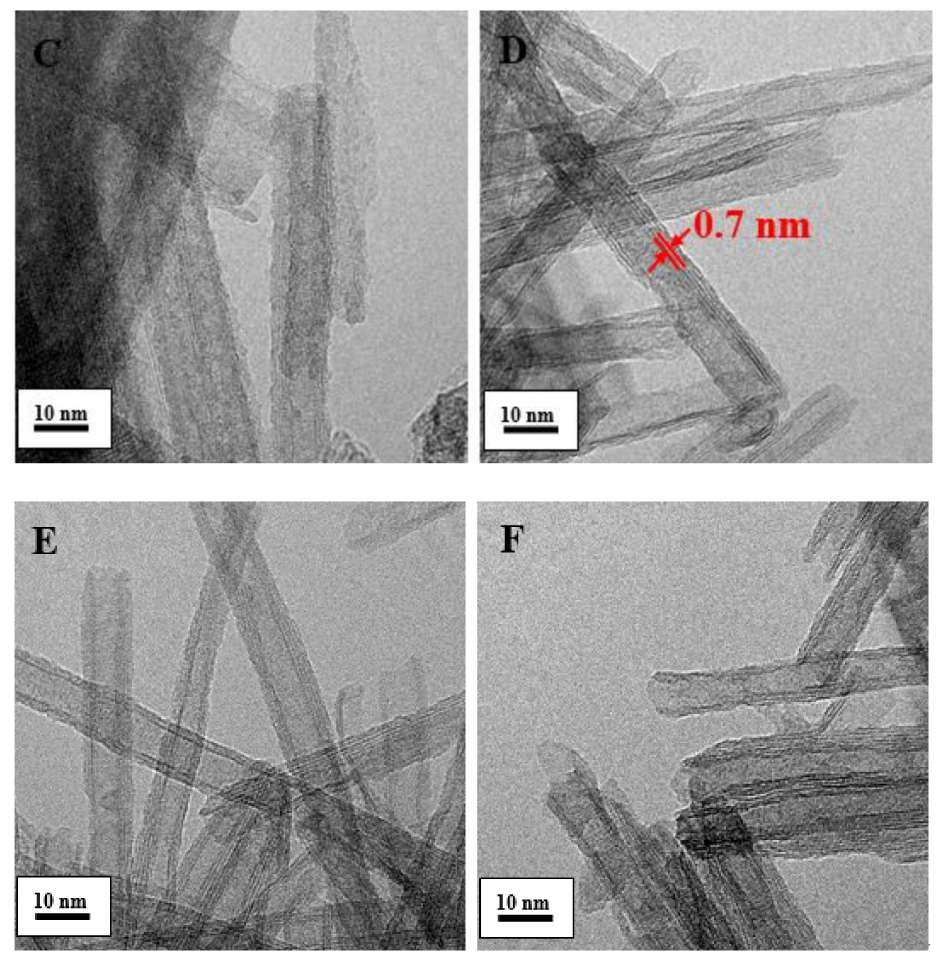
Figure 2. The TEM images of samples: Rh0.5/Li-TNTs-P5 ( A ), Rh0.5/Li-TNTs-B5 ( B ), Rh0.5/Mg-TNTs-P5 ( C ), Rh0.5/Ca-TNTs-P5 ( D ), Rh0.5/Sr-TNTs-P5 fresh ( E ), and used ( F